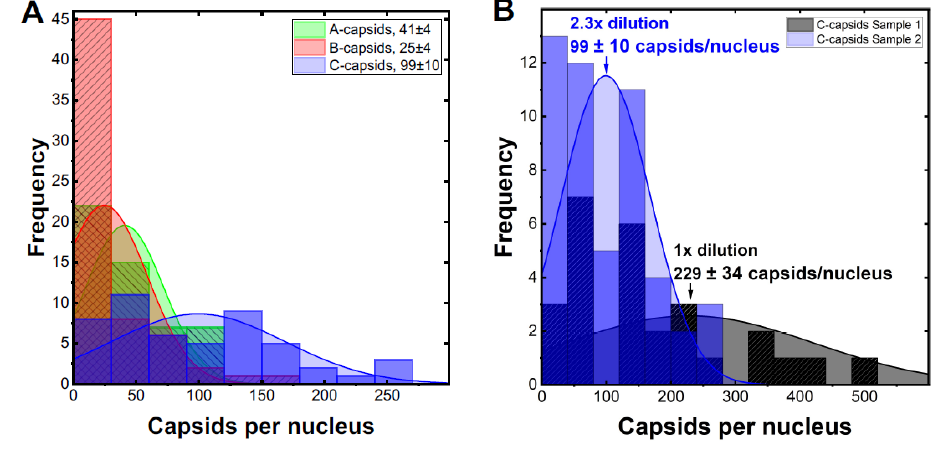
Figure 4. ( A ) Histograms showing the distribution of the computed number of A-, B-, and C-capsids, respectively, docked at the membrane of a reconstituted isolated nucleus. ( B ) Histogram demonstrating that ~2.3 times dilution of C-capsids translates into a ~2.3 times lower number of capsids bound per nucleus. This validates reproducibility of our capsid/nucleus counting approach. At least 50 nuclei were quantified for each type of capsids as well as for each dilution. The fitted Gaussian distributions provide the mean value of capsids/nucleus as well as the standard error.